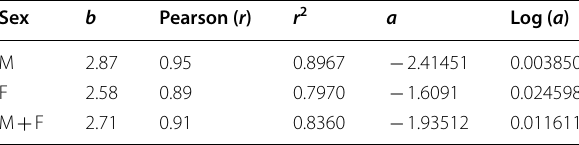
Table 3 The curvilinear relationships of length and weight of pooled, male and female sexes of Charybdis